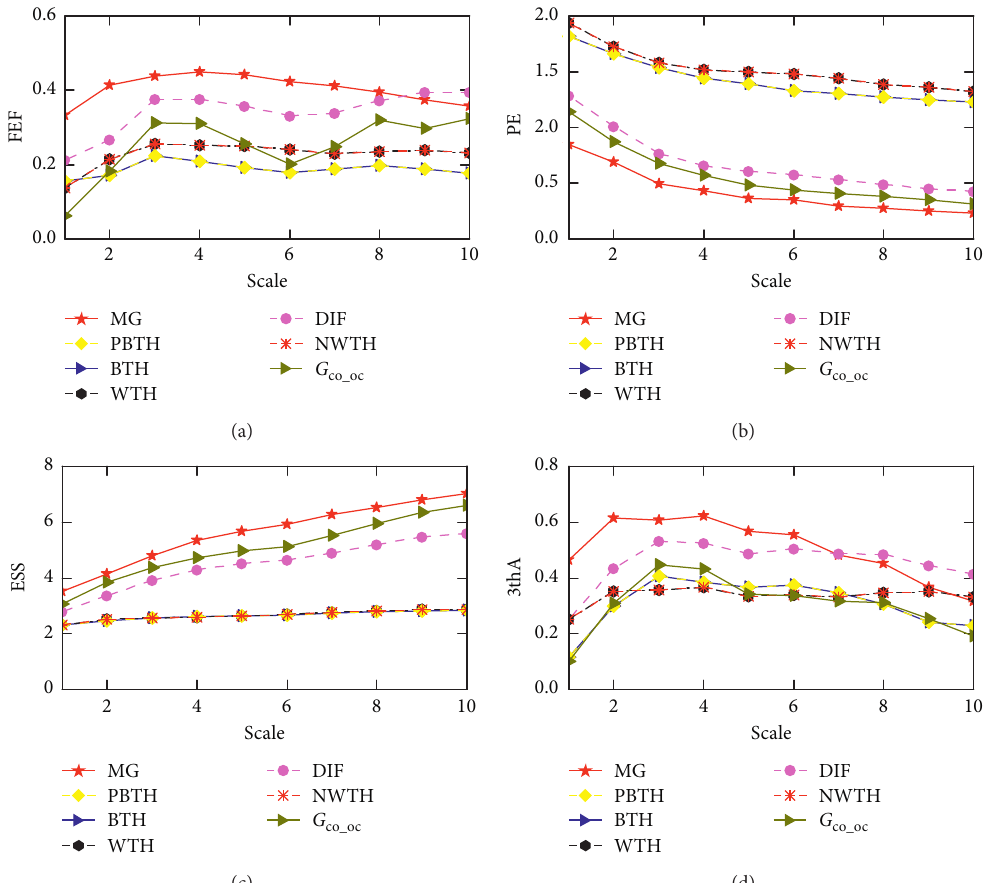
Figure 2: The results of the evaluation indicator varying with scale: (a) feature energy factor; (b) permutation entropy; (c) envelope spectrum sparsity; (d) 3rd harmonic